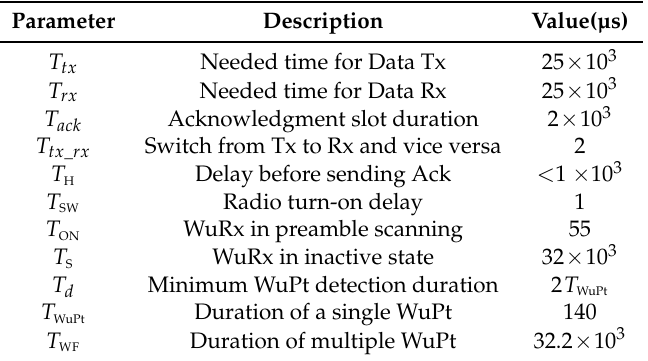
Table 2. Sensor node timing